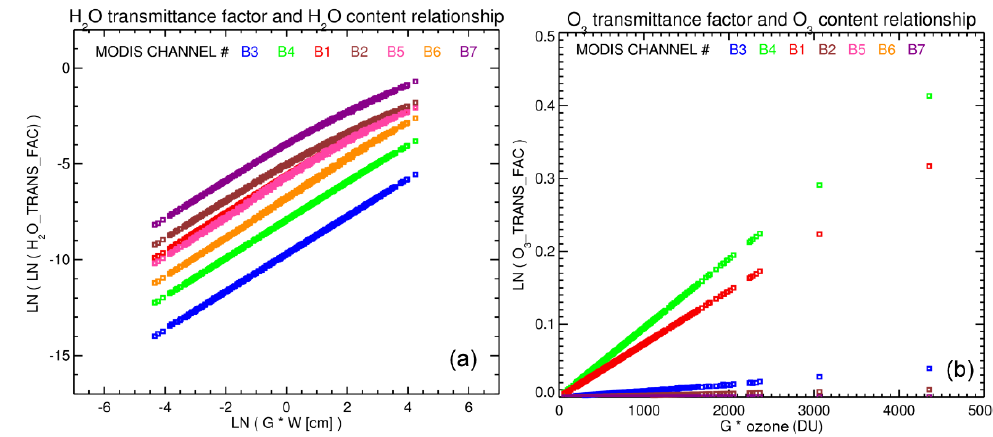
Figure 3. Relationship between gas transmittance factor and gas content in the MODIS channels B1–B7: (a) for H 2 O and (b) for O 3 . Gas content is scaled by the air mass factor ( G ). Gas transmittance was calculated for 52 water vapor and ozone profiles (varying gas concentration) and 10 viewing zenith angles (air mass factors) ranging from 0 to 80 ◦ . These wavelength-dependent empirical relationships are used by the DT aerosol retrieval algorithm for atmospheric gas corrections.